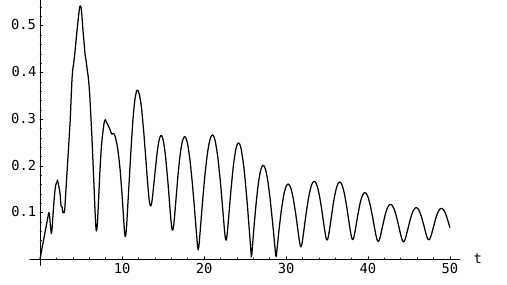
Figure 1. The graph of j u ( L; t ) j for (cid:14) ( x ) = tanh(7 x (cid:0) 3 : 5 L ) :